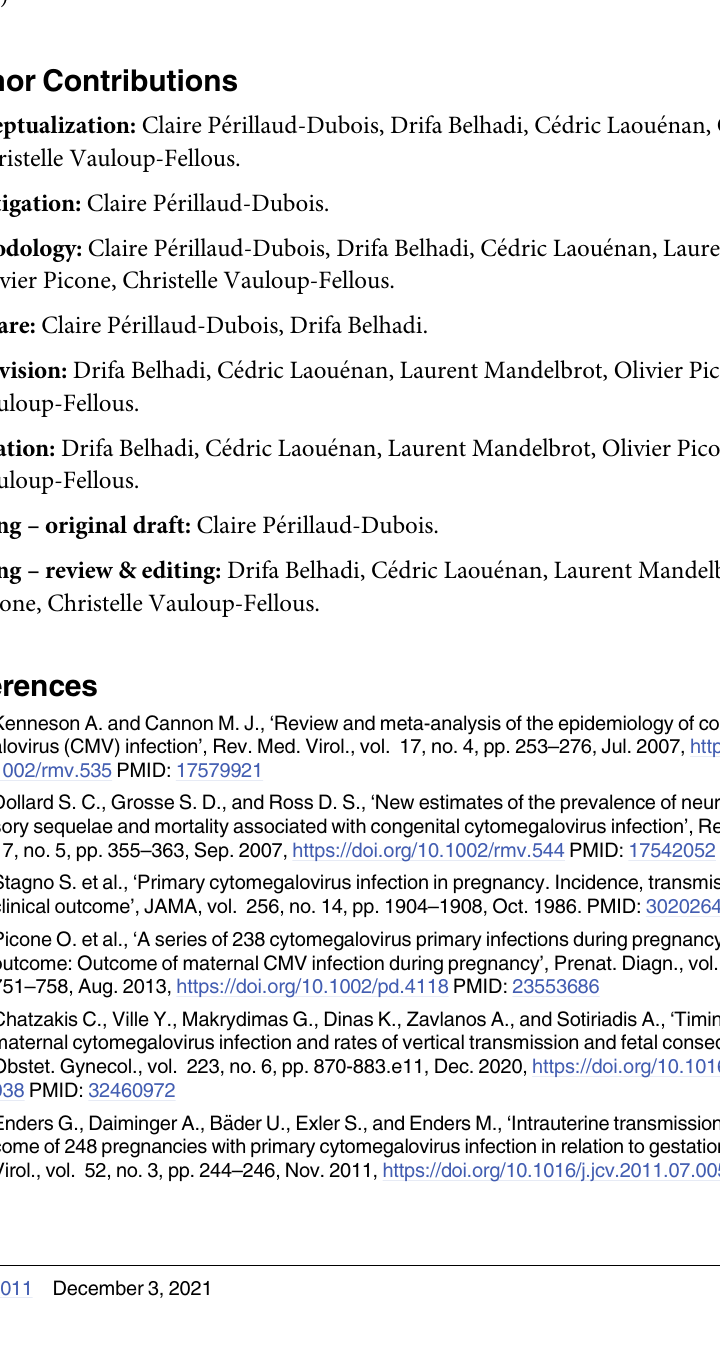
S1 Table. Description of excluded studies on full text and reasons of